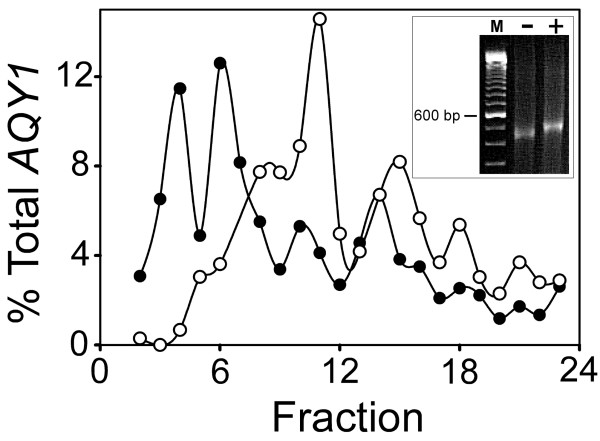
Response of AQY1 to osmotic stress. Cells were either grown in YPD (filled circles) or shocked by sorbitol addition for 30 minutes (open circles). Sucrose gradient centrifugation was performed and analyzed as described in Figure 2. The top of the gradient is to the left and the position of the 80S monosome is marked with the arrow. The 5' termini of the AQY1 transcript before and after osmotic stress are shown in the inset. Rapid amplification of cDNA ends (RACE) was carried out as described in the text (see Materials and methods), using as templates total RNA isolated from cells either grown in YPD (-) or osmotically shocked (+). The image contains the polymerase chain reaction products from the second RACE amplification step after separation by electrophoresis in 2% agarose gel. Lane 'M' contains a 100-basepair ladder.